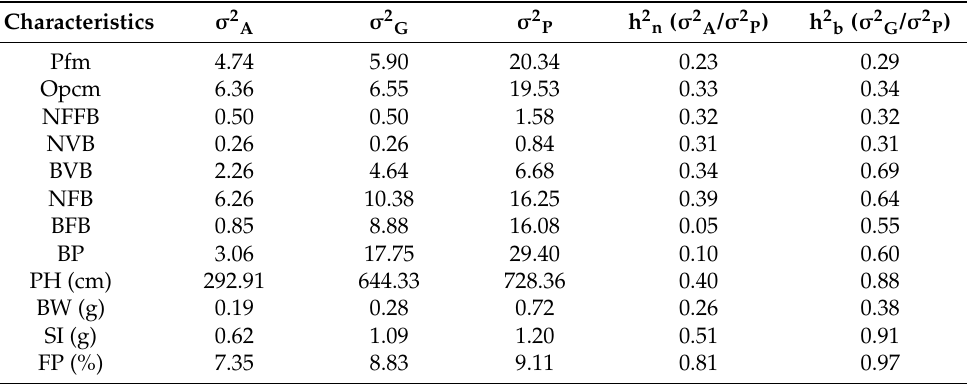
Table 5. Heritability estimates for the traits of 12 cotton lines originated from Burkina Faso and the United States.